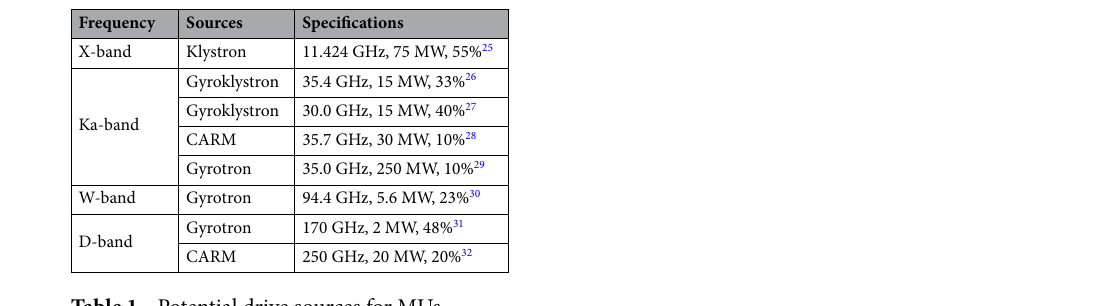
Table 1. Potential drive sources for